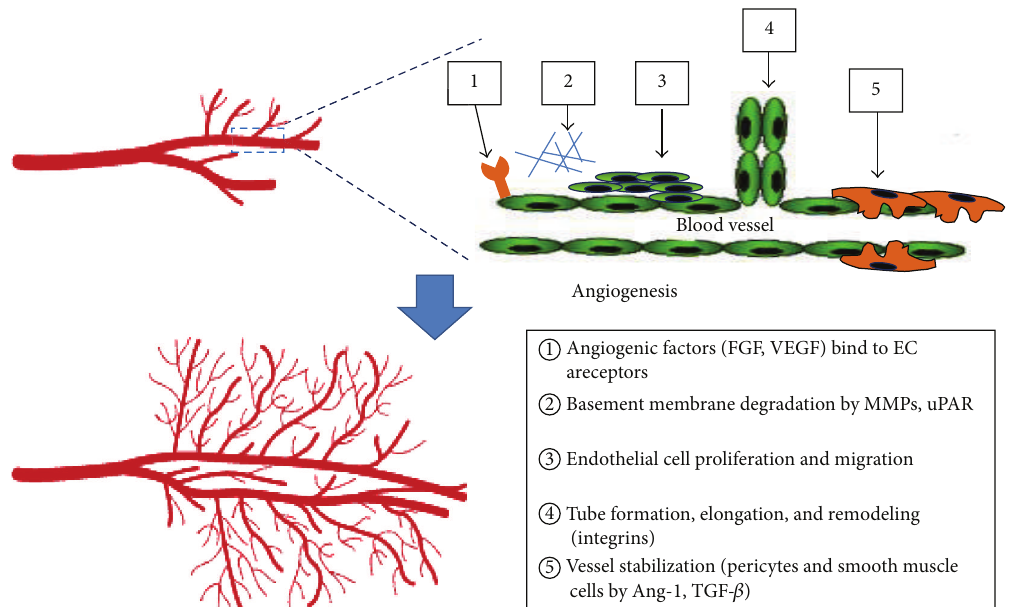
Figure 1: Processes in angiogenesis. (1) Angiogenic factors bind to their receptors on endothelial cells and activate the signal transduction pathways. (2) Matrix metalloproteinases are activated, and they degrade the extracellular matrix. (3) Endothelial cells migrate out of the preexisting capillary wall and proliferate. (4) Integrins are expressed by endothelial cells, facilitating their adhesion to the extracellular matrix